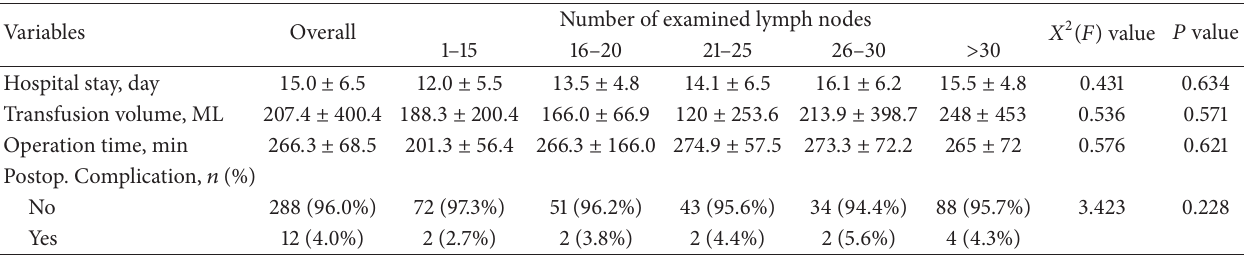
Table 2: Correlation between number of examined lymph nodes and clinical